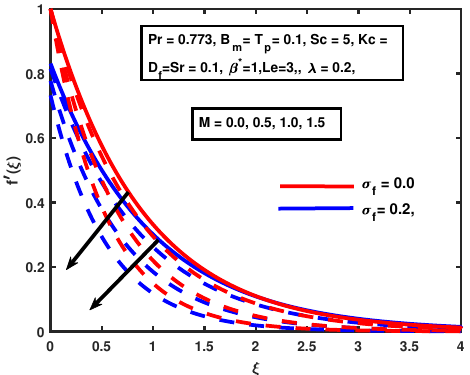
Figure 3. The impact of f (cid:48) ( ξ ) on magnetic M and hydrodynamic slip σ f